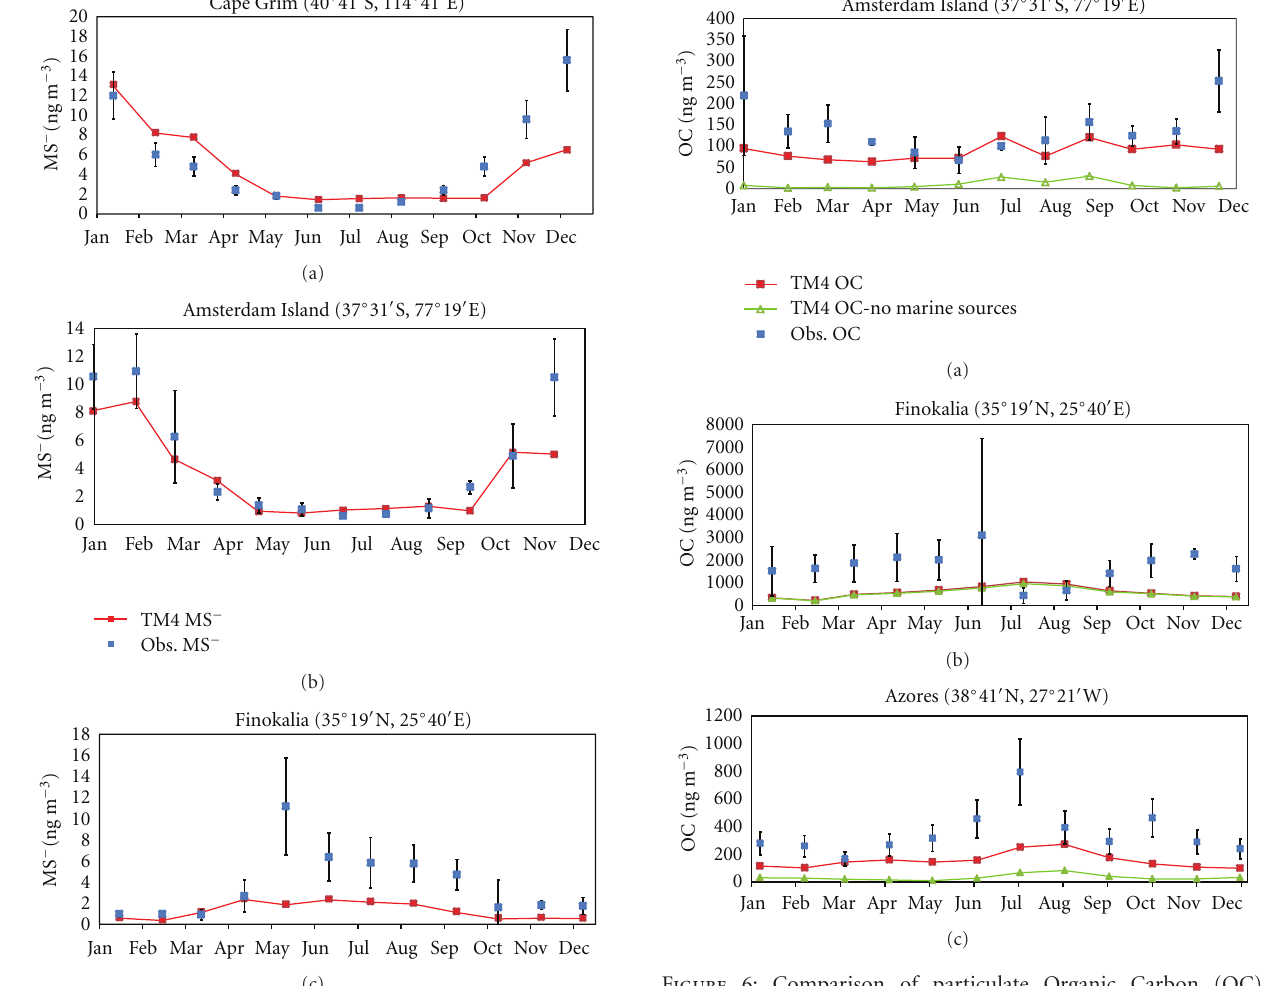
Figure 6: Comparison of particulate Organic Carbon (OC) observations with model results. Observed OC (blue squares with standard deviation bars), modelled OC-S1 accounting for the oceanic sources of OA (red line—squares), and neglecting the marine OA sources (green line—triangles) at marine locations. (a) Amsterdam Island (37 ◦ 31 (cid:5) S, 77 ◦ 19 (cid:5) E; [41]) and (b) Finokalia (35 ◦ 19 (cid:5) N, 25 ◦ 40 (cid:5) E; [42] and [43]), (c) Azores (38 ◦ 41 (cid:5) N, 27 ◦ 21 (cid:5) W; from Pio et al. [44]. All values are in ngm − 3